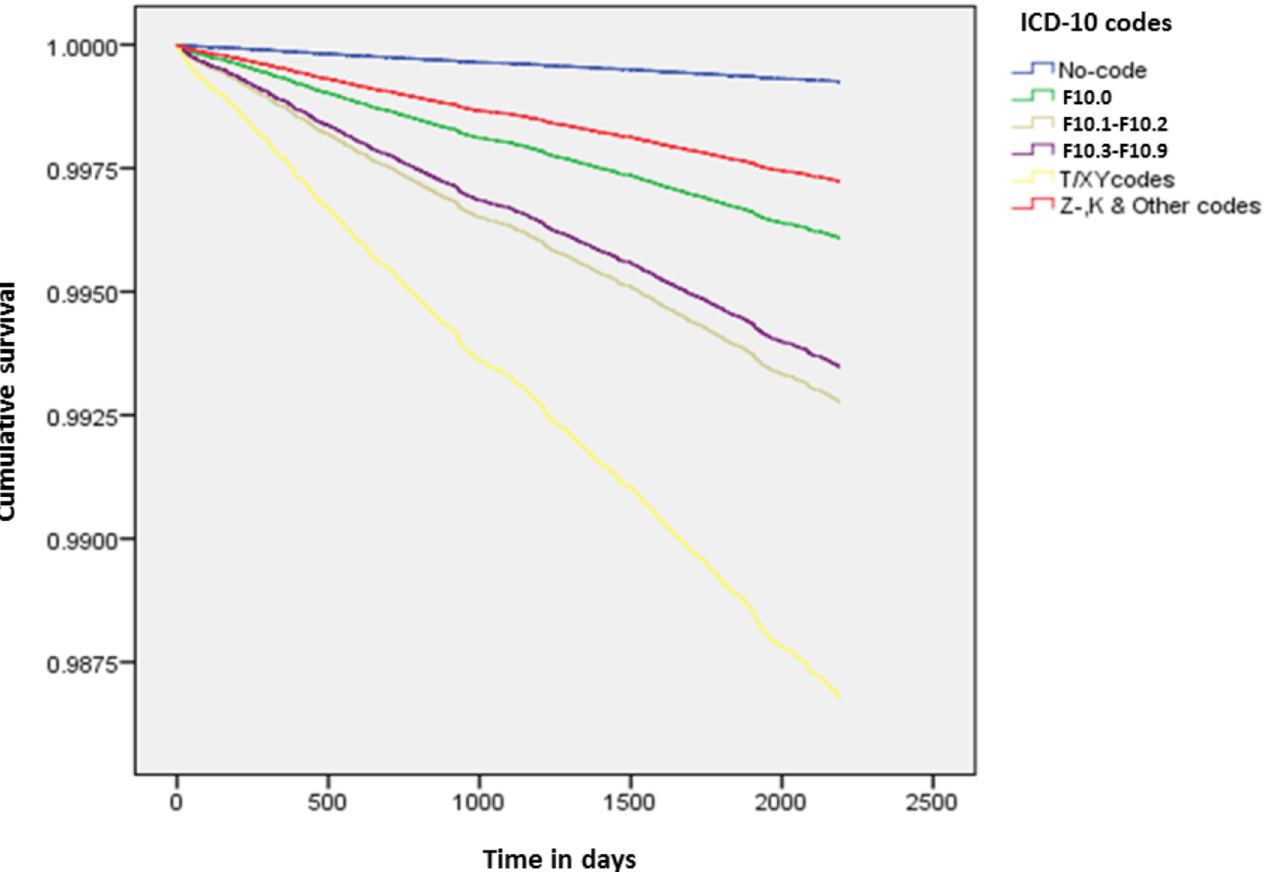
Fig 2. Cumulative survival plot for diagnostic categories of alcohol-related admissions: